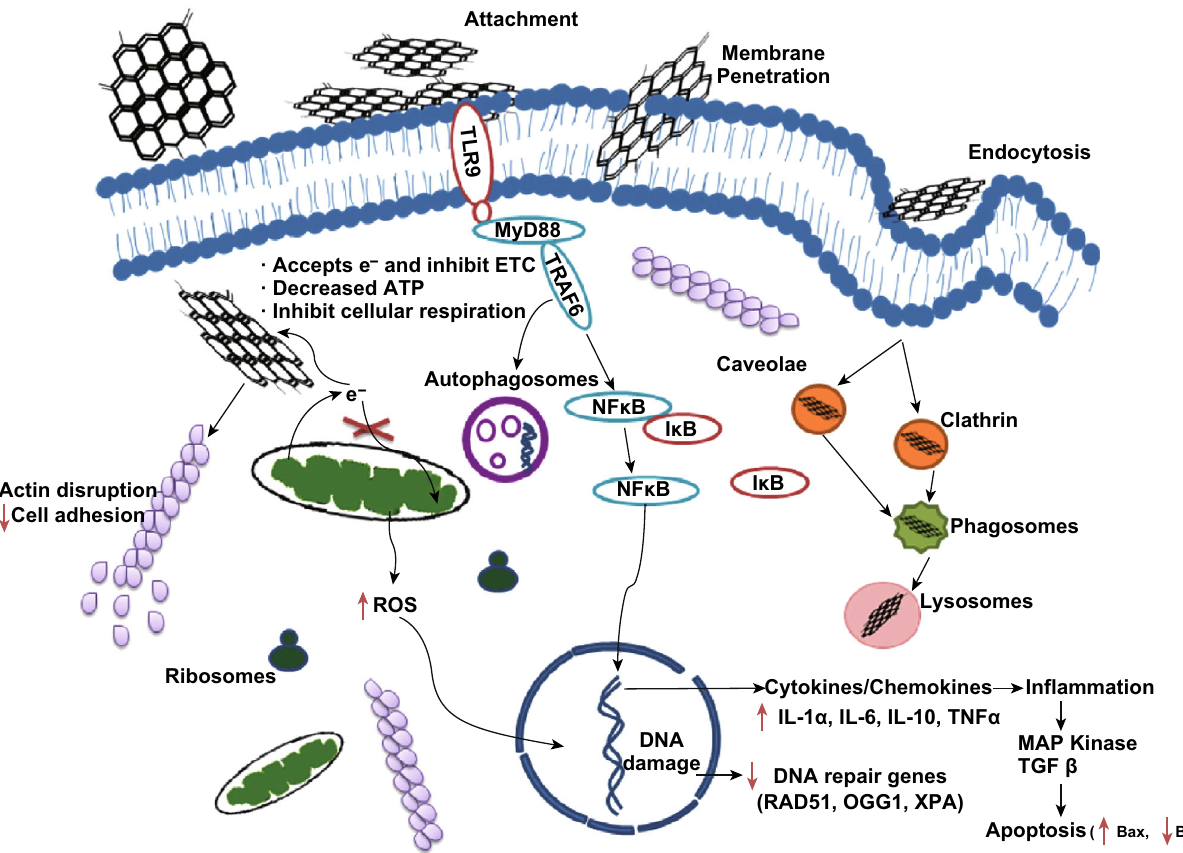
Fig. 7 Mechanisms of toxicity of GBNs [151]. Copyright (cid:2) 2016 Elsevier